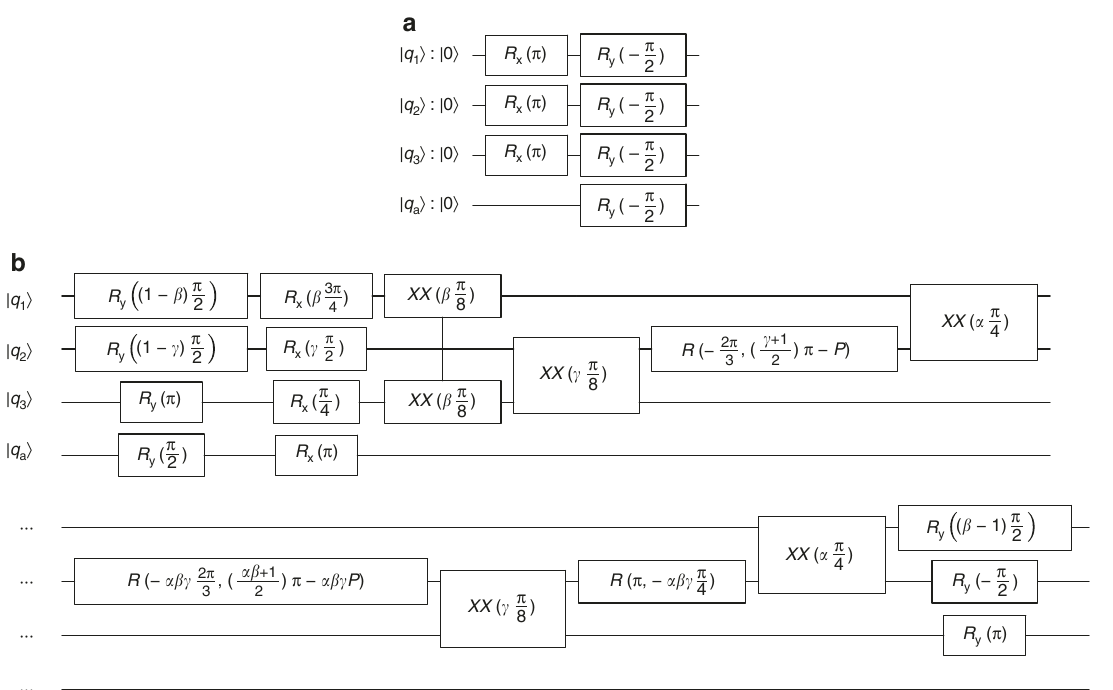
Fig. 8 Grover search algorithm circuits. Grover search algorithm implementation by substage using XX ( χ ), R x ( θ ), R y ( θ ), and R ( θ , ϕ ) gates. The circuits q(cid:3) (cid:4) ffiffi shown are for use with Boolean oracles; removing the ancilla qubit | q a 〉 produces the necessary circuits for use with a phase oracle. Let α = sgn( χ 12 ), β = sgn 2 . a Grover initialization stage implementation. b Grover ampli fi cation stage ( χ 1t ), γ = sgn( χ 2t ), and P ¼ arcsin 3